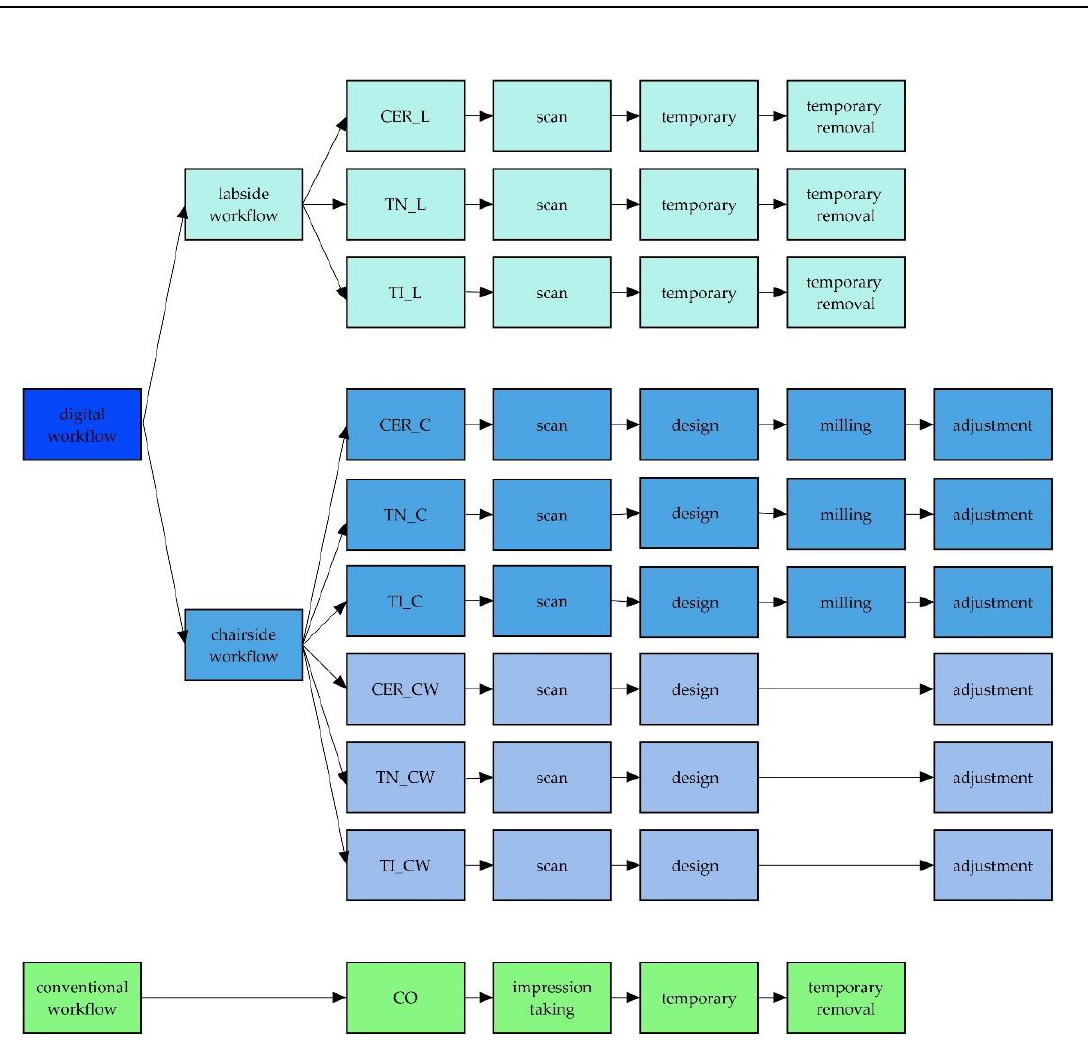
Figure 2. Workflows and test groups with their individual processing steps.